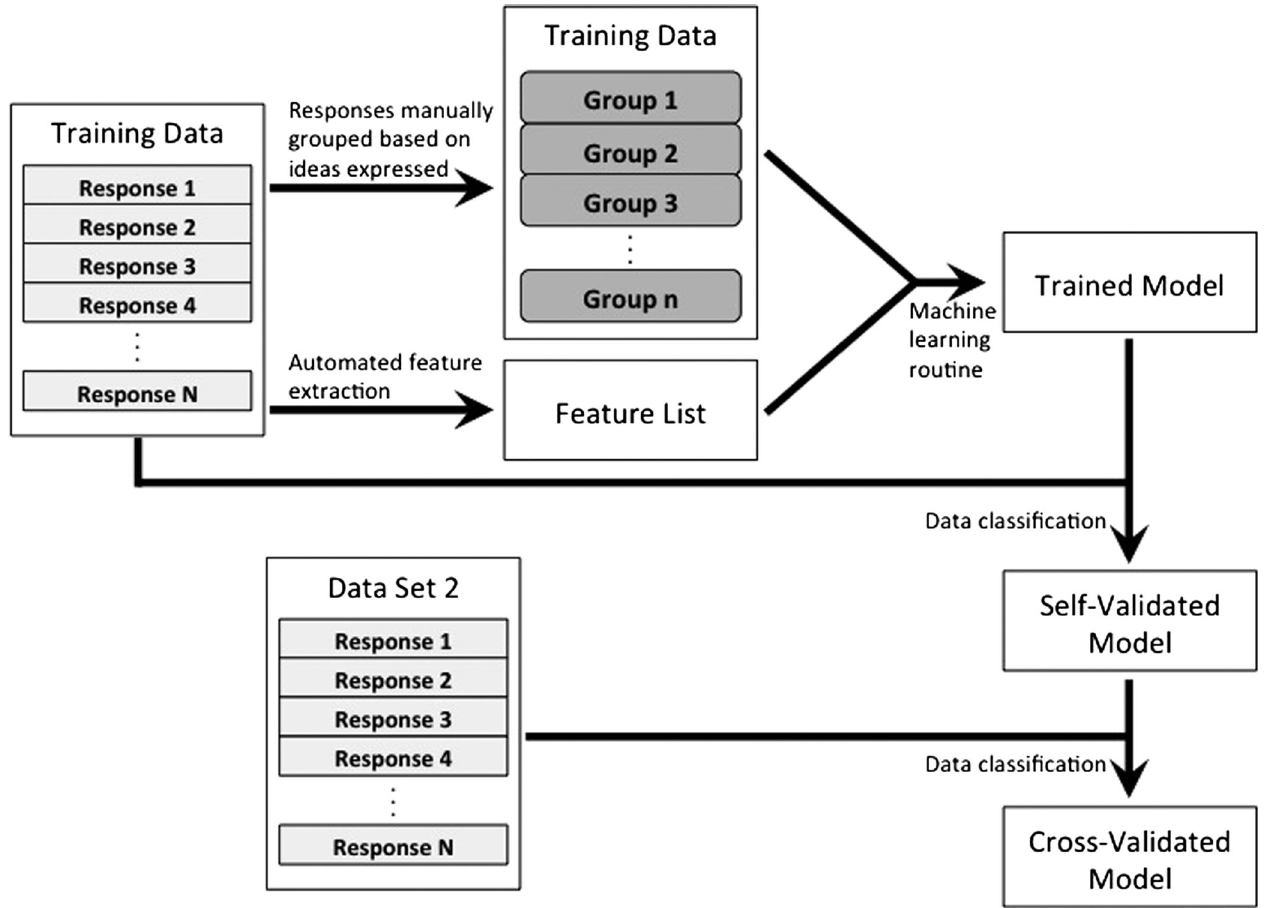
FIG. 2. Flowchart indicating the general analysis scheme followed in this